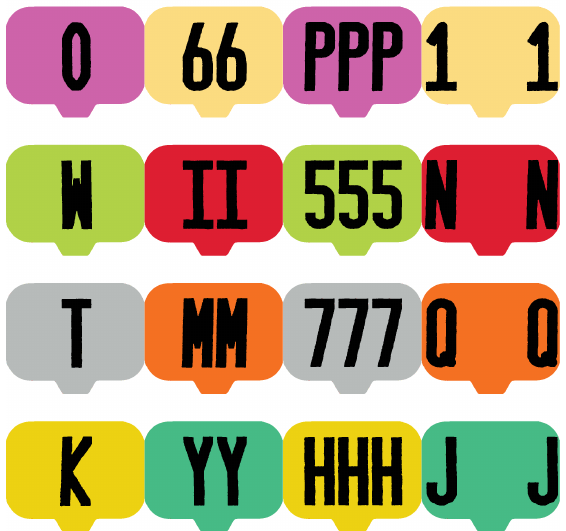
Figure 5. The 16 unique ear tags used in this work to identify individual pigs. The tags use alphanumeric characters printed on Destron Fearing TM Hogmax ear tags.